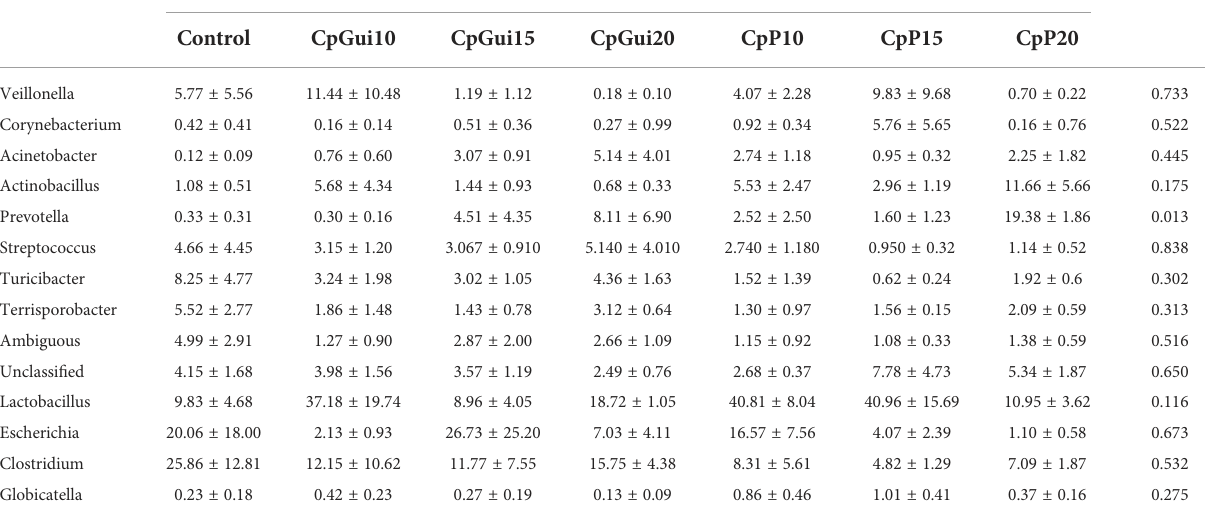
TABLE 8 A diet-related taxonomic pro fi le (genus level, ≥ 1% relative abundance) of the stomach bacterial community in fattening pigs. Items Treatment P